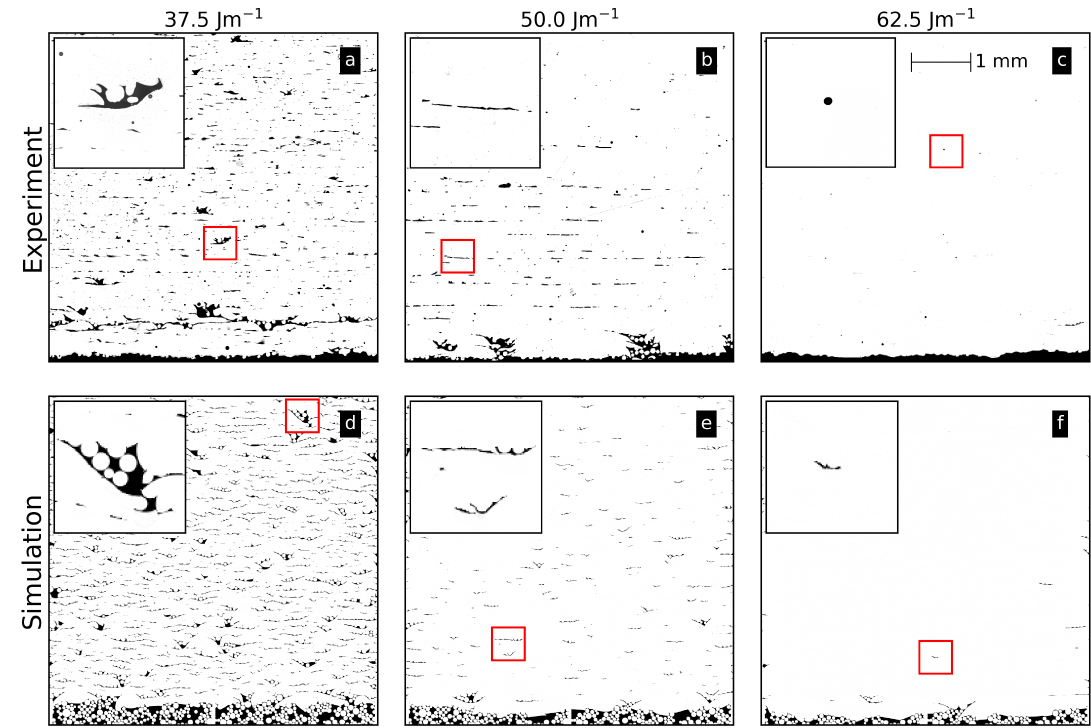
Figure 3. Comparison between simulation and experimental microsections for different line energies and a constant scan velocity of 20m/s. The insets depict an enlarged area of multi-layer binding faults ( a , d ), single-layer binding faults ( b , e , f ), and gas pores ( c